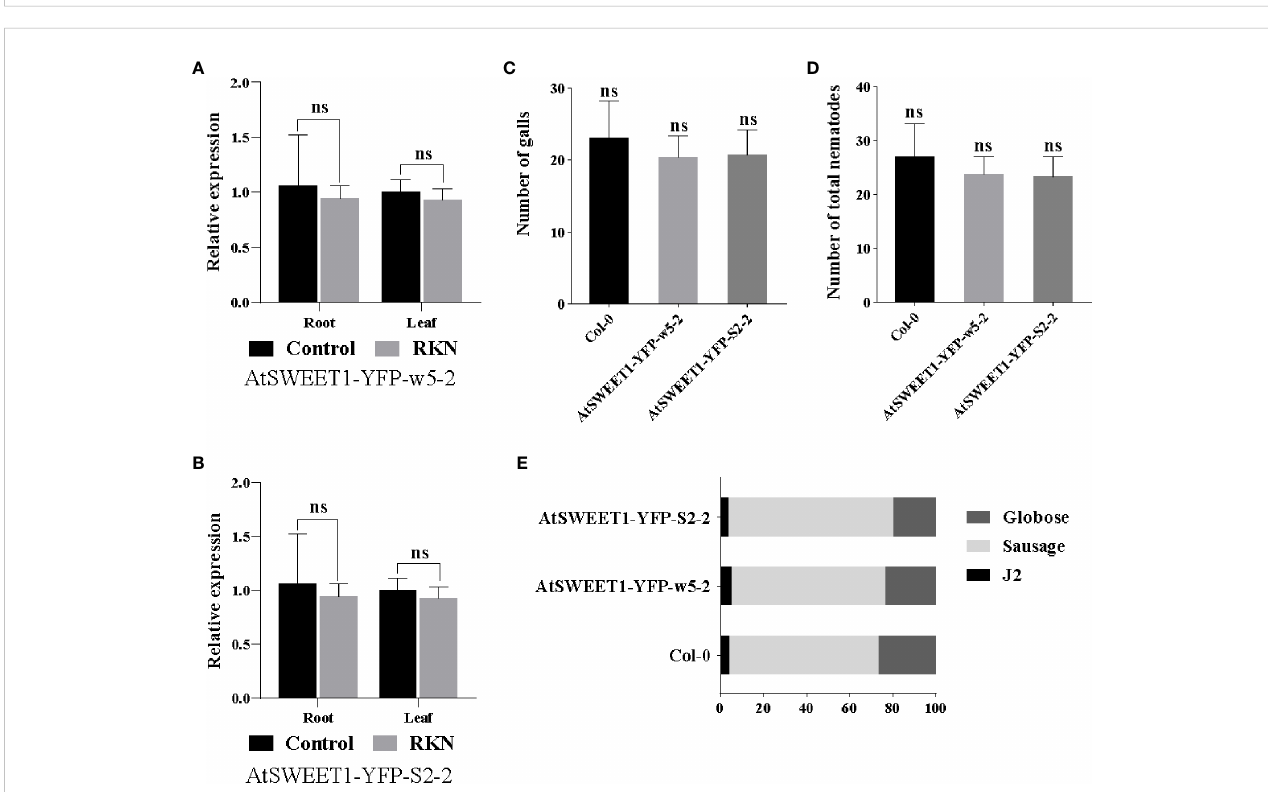
FIGURE 4 Response of A. thaliana complemented (AtSWEET1-YFP-w5-2 and AtSWEET1-YFP-S2-2) and wild-type Col-0 plants to M. incognita infection. (A, B) The relative expression levels of the AtSWEET1 gene in A.thaliana complemented plants were analyzed using quantitative reverse transcription PCR. Using col-0 plants as control, fi ve biological replicates and three technical repeats were performed per sample. The Actin 8 gene was used as an internal control. (C) The number of galls in the root of Arabidopsis inoculated with M. incognita at 18 dpi. There is no signi fi cant difference between complemented plants and Col-0 plants. (D) The total number of nematode-infected Arabidopsis . (E) Percentage of nematodes corresponding to different developmental stages (J2 stage; Sausage stage; Globose stage) in the complemented plants and Col-0 plants at 18 dpi (n = 15). Data are presented as mean ± SD, and p-values were analyzed using student ’ s t-test. ns, no signi fi cant